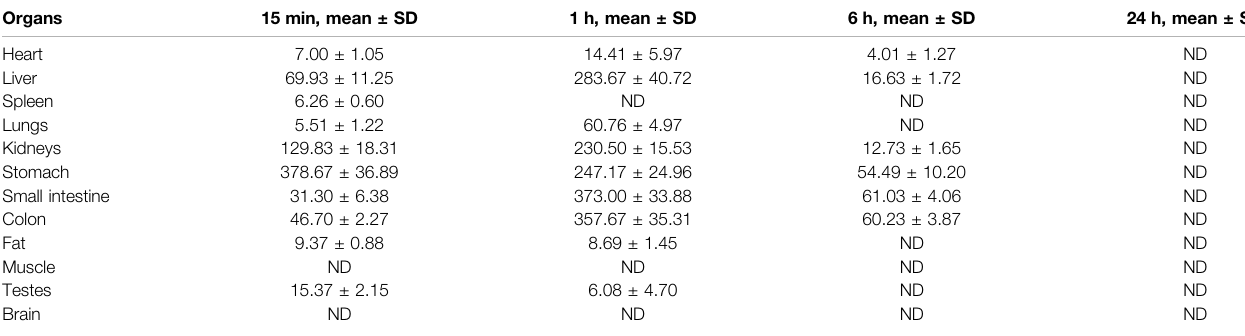
TABLE 6 | Main organ tissue concentrations in mice after oral administration of YWS01125 . Organs